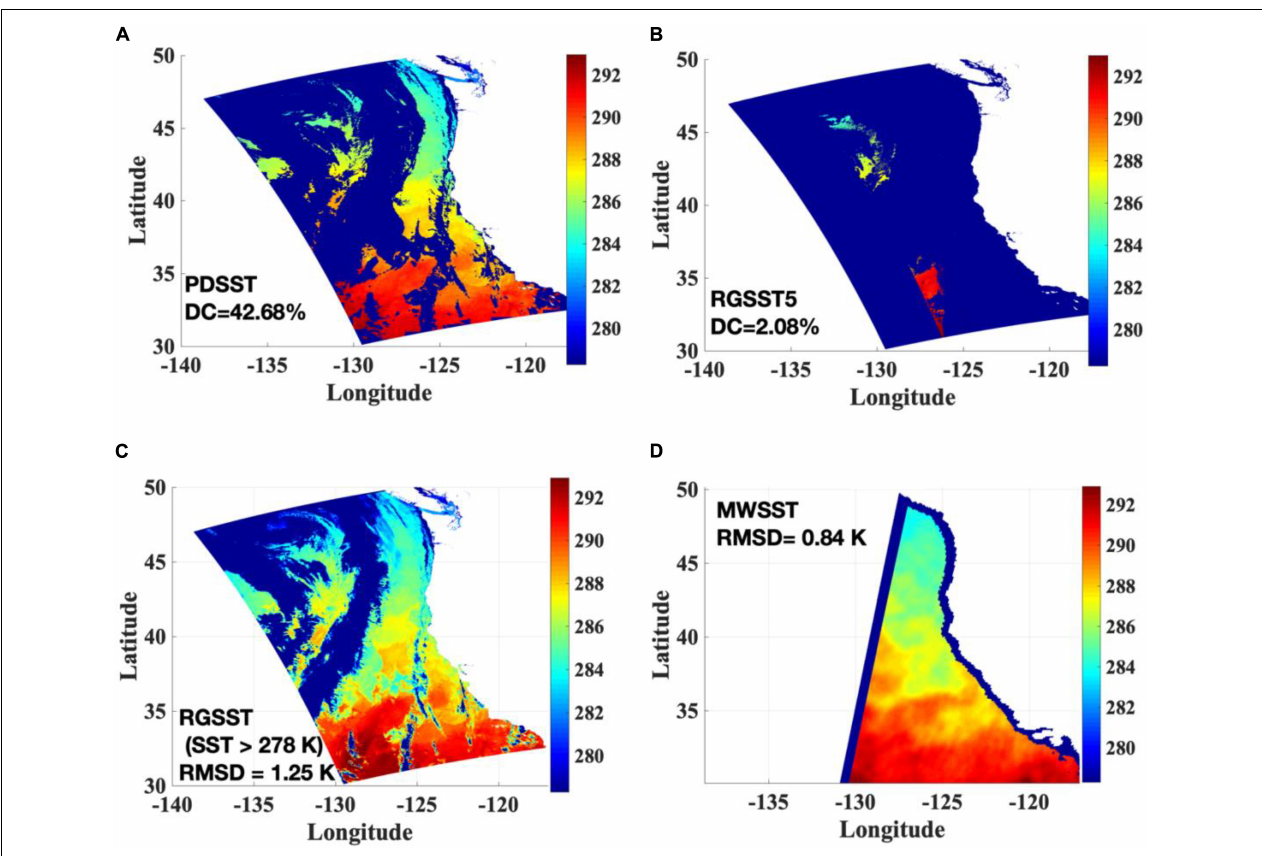
FIGURE 3 | Comparison of daytime SST retrieval maps for California coast: (A) PDSST from MODIS-AQUA, (B) RGSST5 from MODIS-AQUA, (C) full-swath RGSST from MODIS-AQUA using a constraint of SST < 278 K, and (D) MW SST from AMSR2. DC stands for data coverage in percentage and RMSD is the root mean squared difference from matched in situ . The ranges of longitude and latitude from –180 ◦ to 180 ◦ and from –90 ◦ to 90 ◦ represent West to East and South to North, respectively. Unit of color bar is K. The color value of the darkest blue represents the Ocean portion.